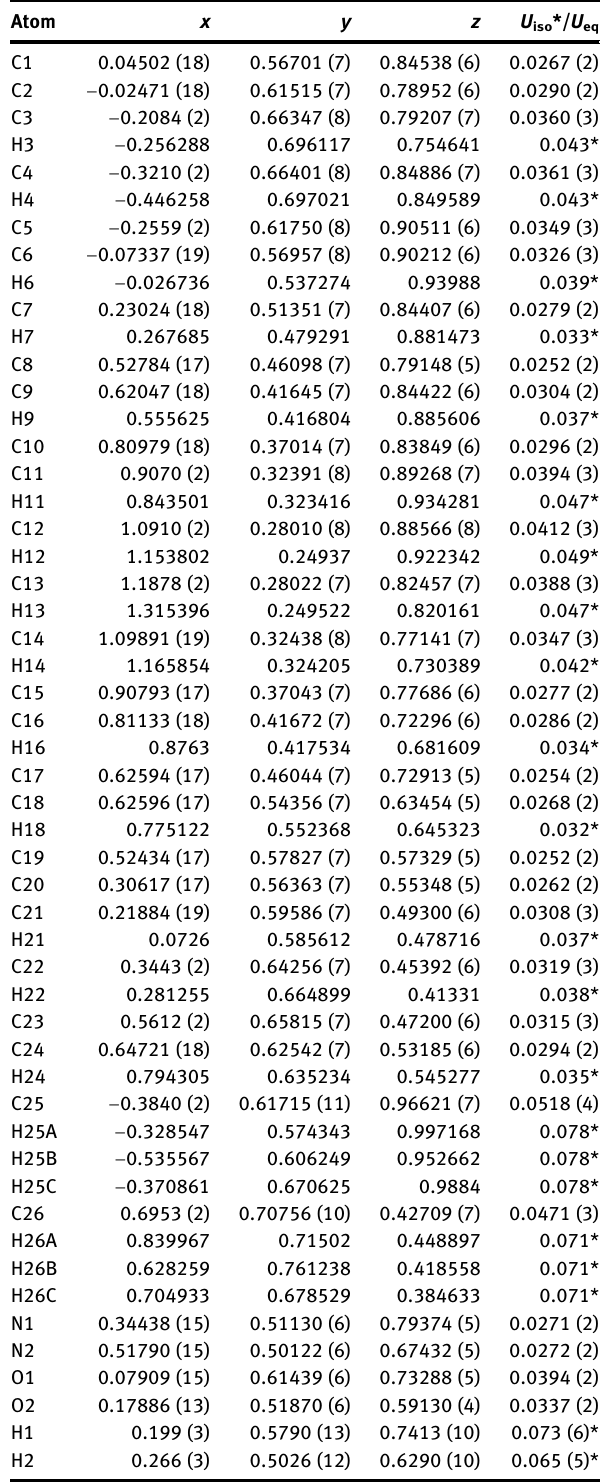
Table  : Fractional atomic coordinates and isotropic or equivalent isotropic displacement parameters (Å 